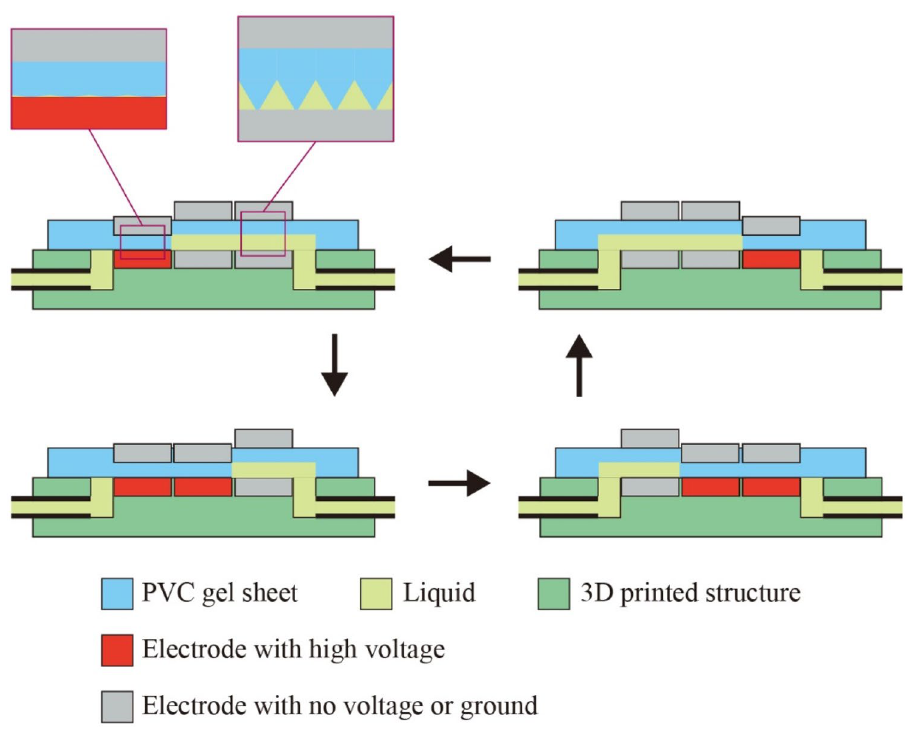
Figure 2. Working principle of the PVC gel